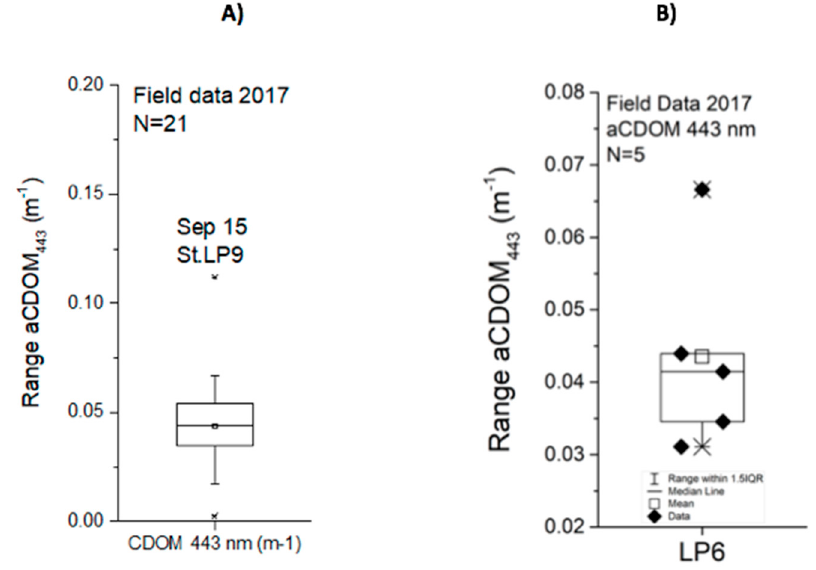
Figure 3. Box plots for field data showing the median, mean and data including the extreme values ( A ) Summary of the absorption coefficient of colored dissolved organic matter (aCDOM) at 443 nm field data for the year 2017. ( B ) The absorption coefficient of colored dissolved organic matter (aCDOM) at 443 nm field data on station LP6, alias Turrumote II, for 2017. Table 1. Statistics for five time periods on ADG443_NN product from Sentinel 3A.